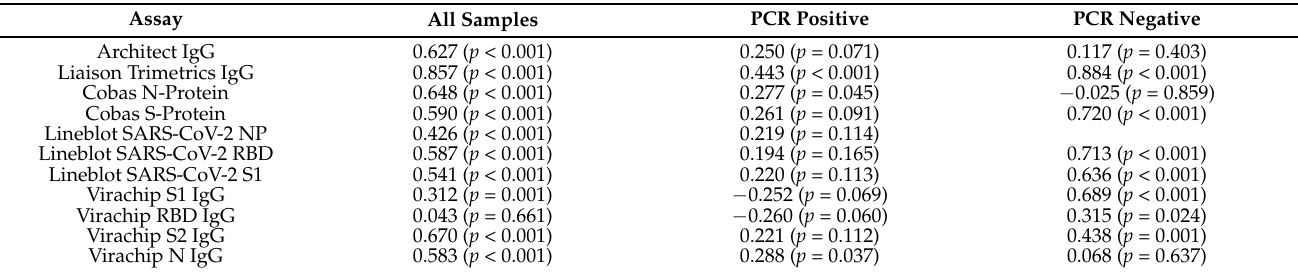
Table A1. Spearman correlation coefficients between all individual assays and cPass neutralizing antibody levels.